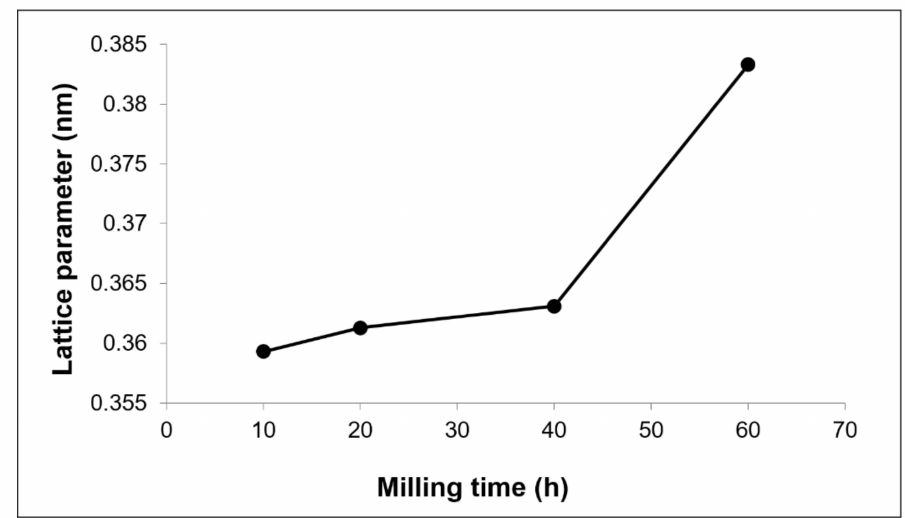
Figure 4. Cu lattice parameter of Cu-W-C powder at various milling time.